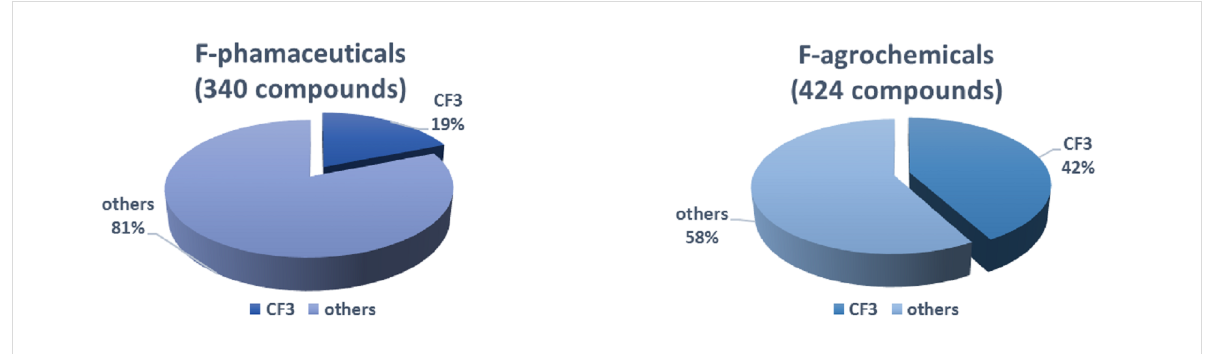
Figure 1: Ratios of CF 3 -containing drugs in marketed fluoro-pharmaceuticals and registered fluoro-agrochemicals in the world.